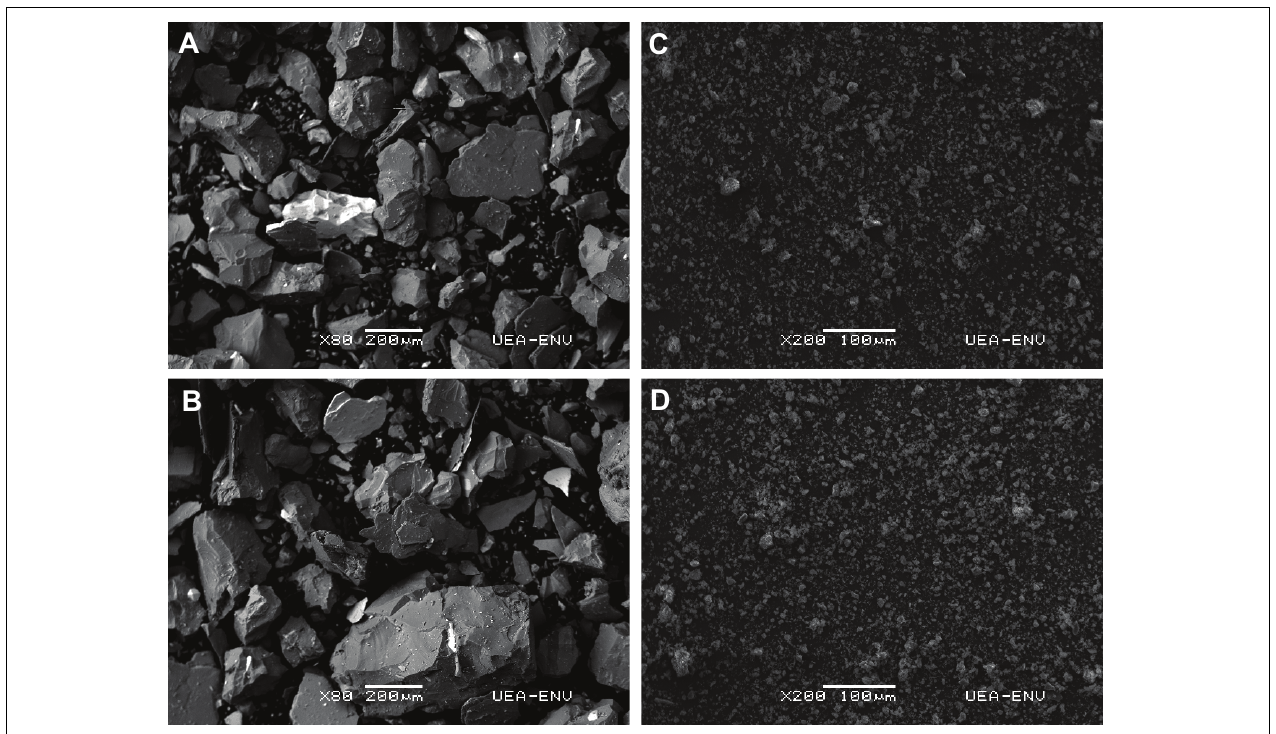
FIGURE 12 | Scanning Electron Microscope (SEM) images of the inert mine tailings (0% C org treatment) (A,B) and background mudflat sediments at the experimental site (C,D) . Scale bars are shown in each